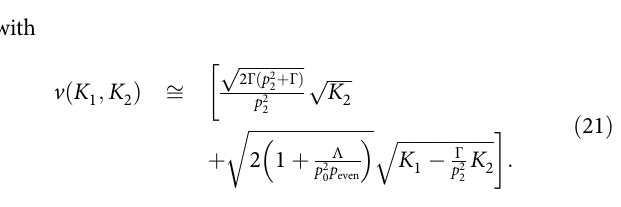
Numerical simulation . We simulated the key rate G / N function of distance L between Alice and Bob when they are fi ber- linked to Charlie with a loss of 0.2 dB/km. We assumed a ¼ 0 : 3 for Charlie ’ s apparatus. The detection ef fi ciency of η d ; μ ; p ; p ; p ; p Þ are optimized for each parameters ð μ ; μ 0 10 11 2 1 2 NATURE COMMUNICATIONS| (2019) 10:3140